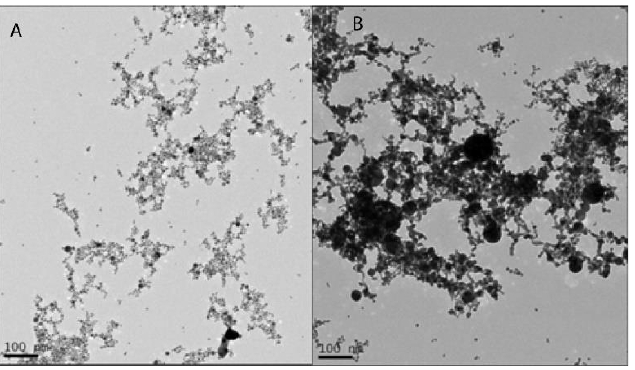
Figure 4. Transmission Electron Microscopy (TEM) images of AuNP-1 ( A ) and AuNP-2 ( B ) demon- strated spherical morphologies and diameter variation, allowing the observation of differences in size and size distribution of both batches, which agrees with PDI and DLS results. Scale bars 100 nm.